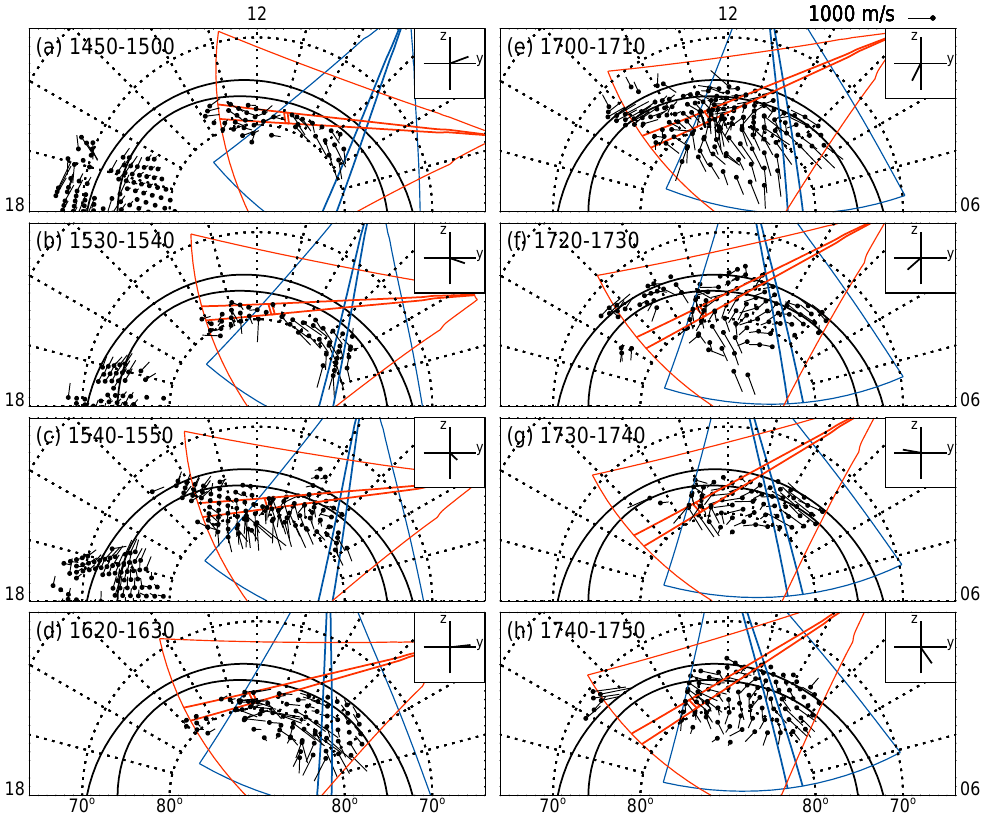
Fig. 3. Two-dimensional convection velocities during selected intervals of interest. Dashed concentric circles represent contours of magnetic latitude, and the straight dashed lines represent hours of magnetic local time, with 12MLT at the top of the plots. The merged vectors were obtained by reconstructing a horizontal ionospheric convection velocity from two overlapping line of sight velocity components measured by two SuperDARN radars. The line of sight data were averaged over 10min. The corresponding averaged IMF orientation in the B y and B z GSM plane is plotted in the upper right-hand corner of each panel, and each corresponding 10-min interval is marked at the top of Fig. 2, with the labels corresponding to the panel labels in this